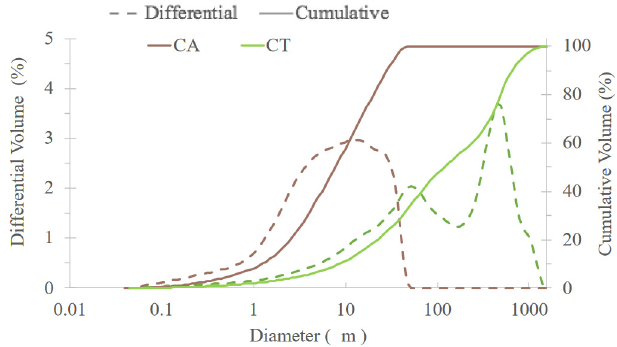
Figure 2. Diffractograms of CA and CT biomass fly ashes.